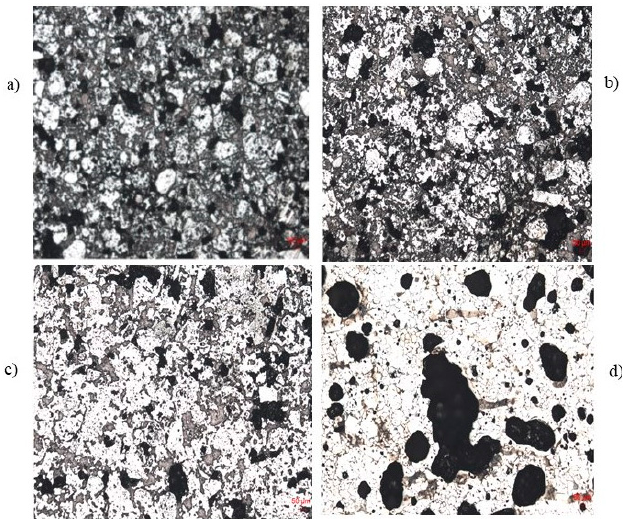
Figure 2. Morphological change in sintered Blend 2 after sintering at: ( a ) 1373 K; ( b ) 1423 K; ( c ) 1473 K; and ( d ) 1523 K.